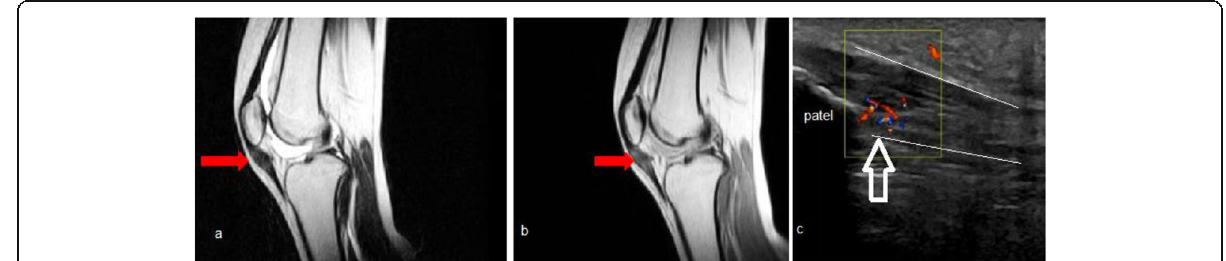
Fig. 8 a , b MRI images. c Color Doppler ultrasound image for infrapatellar tendinopathy. a Sagittal PD and b sagittal T2-weighted images demonstrated thickened infrapatellar tendon at its patellar attachment with an intra-substance areas of intermediate T1 and T2 signal intensity with no evidence of total discontinuity (red arrows) c showing thickening of the tendon (between the white lines) with intra-tendinous hyperemia (open white arrow)